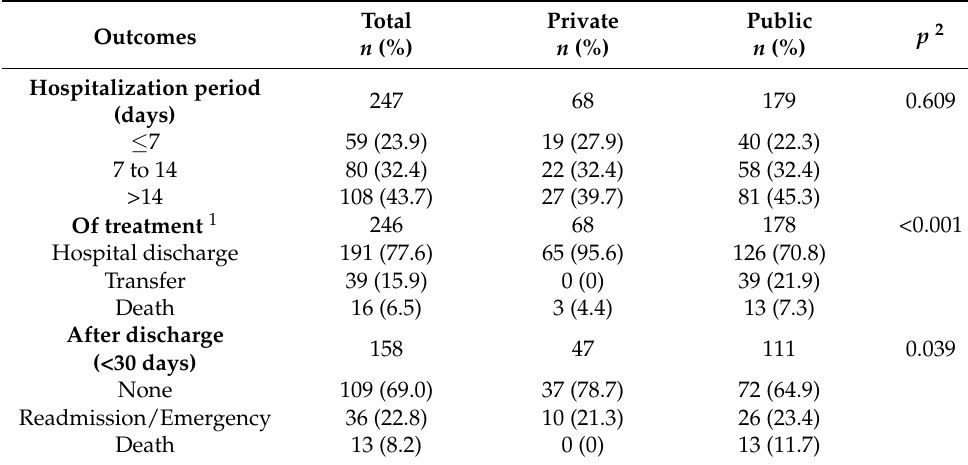
Table 3. Comparison of in-hospital and post-discharge clinical outcomes ( ≤ 30 days) among hospital- ized patients with heart failure, in the public and private health systems in Brazil, from April 2018 to January 2021. Total Outcomes